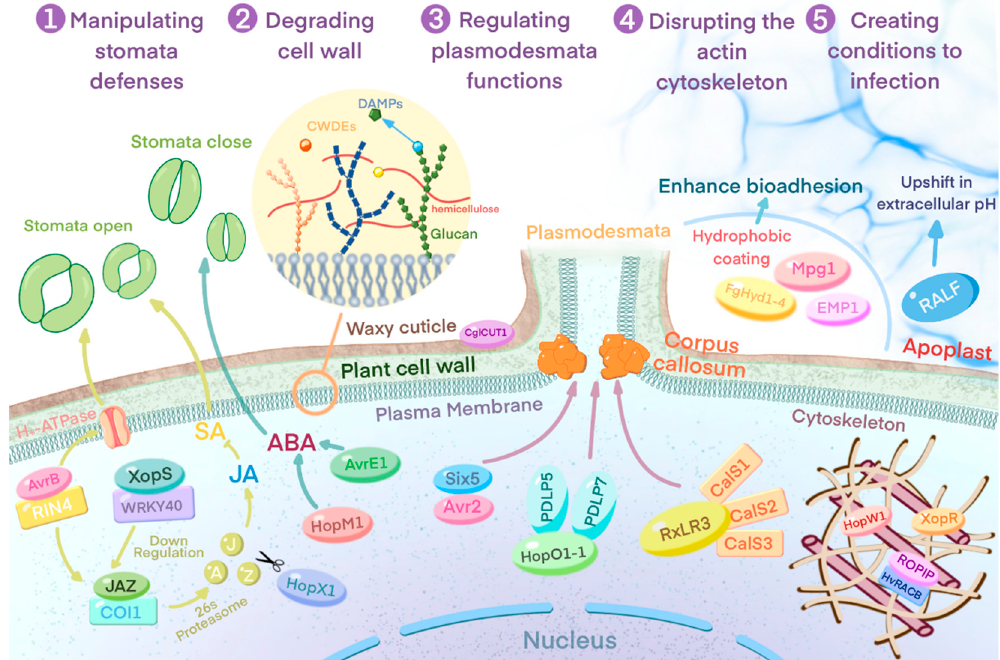
Figure 2. Schematic diagram of effectors that break physical barriers to infestation and regulate the infestation environment. Effectors promote infestation by regulating stomata, degrading cell walls, regulating intercellular filament function, disrupting the cytoskeleton, and creating conditions con- ducive to infestation. P. syringae AvrB interacts with RIN4 protein to promote COI1 and JAZ protein binding and enhance plasma membrane H + -ATPase AHA1 activity. HopX1 inhibits stomatal im- munity by degrading multiple JAZ transcriptional repressors leading to JA activation. xopS stabi- lizes WRKY40 and decreases JAZ expression. HopM1 and AvrE1 target the ABA signaling pathway, increase ABA accumulation, and induce stomatal closure. Fusarium oxysporum Avr2 and Six5 inter- act with intercellular filaments to enlarge the pore size. The oomycete pathogen Phytophthora brassi- cae RxLR3 effector physically interacts with callus synthases CalS1, CalS2 and CalS3 to impede cal- lus accumulation in intercellular hyphae. P. syringae HopO1-1 interacts with and destabilizes the PD proteins PDLP7 and PDLP5. HopW1 disrupts the actin cytoskeleton by forming complexes with actin. Bradyrhizobium graminearum ROPIP targets the barley ROP GTPase HvRACB and manipulates host cell microtubule organization to facilitate its own cell entry. Xanthomonas oleifera T3E XopR binds to actin in the cell cortex to manipulate actin assembly and disrupt the host actin cytoskeleton. The hydrophobic protein MPG1 in Fusarium inermis , FgHyd1~FgHyd4 in F. graminearum , and the extracellular matrix protein EMP1 in F. graminearum can create hydrophobic spaces and participate in appressorium development. Ralf-like effectors can cause an increase in extracellular pH to pro- mote the invasive growth of the fungus. Overall, effectors favor their own infestation by modifying the structural properties of plant cells and environmental conditions. 3.1.2. Degradation of Plant Cell Walls Many plant pathogens, especially those lacking specific penetrating structures, se- crete various types of cell-wall-degrading enzymes (CWDEs) to disrupt host cells and promote colonization, including glycoside hydrolases, glycosyltransferases, and pectin ly- ases to hydrolyze cell wall components (Figure 2) [67,68]. This mechanism is particularly common in necrotrophic pathogens, with certain CWDEs correlating positively with vir- ulence in Botrytis cinerea , V. dahliae and Mycosphaerella graminicola [69–73]. A fraction of CWDEs target the cuticle on the cell wall, and the waxy cuticle is pro- tective against biotic and abiotic stresses [74,75]. Colletotrichum gloeosporioides , the patho- gen of oil tea anthracnose, secretes the cutinase CglCUT1, which degrades the cuticle dur- ing pathogenesis [76]. Some CWDEs can degrade polysaccharides and cellulose in the cell wall, releasing oligosaccharides as PAMPs to trigger plant immunity [77,78]. M. oryzae